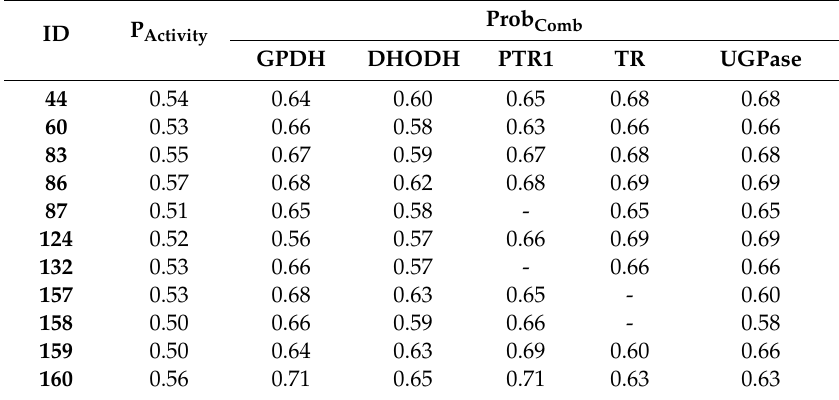
Table 7. Combined probabilities between prediction models and molecular docking analysis for potential activity against L. major